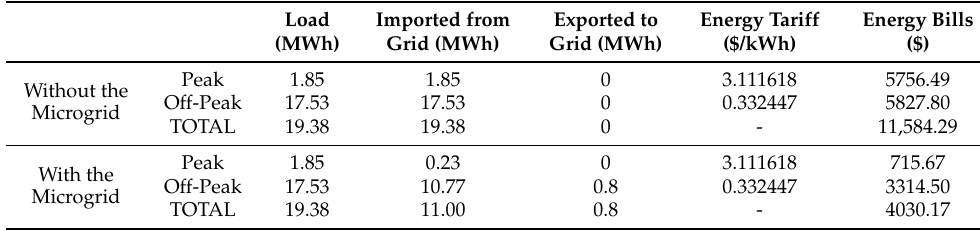
Table 8. General comparison for cases with and without the ASC- µ Grid for two simulation